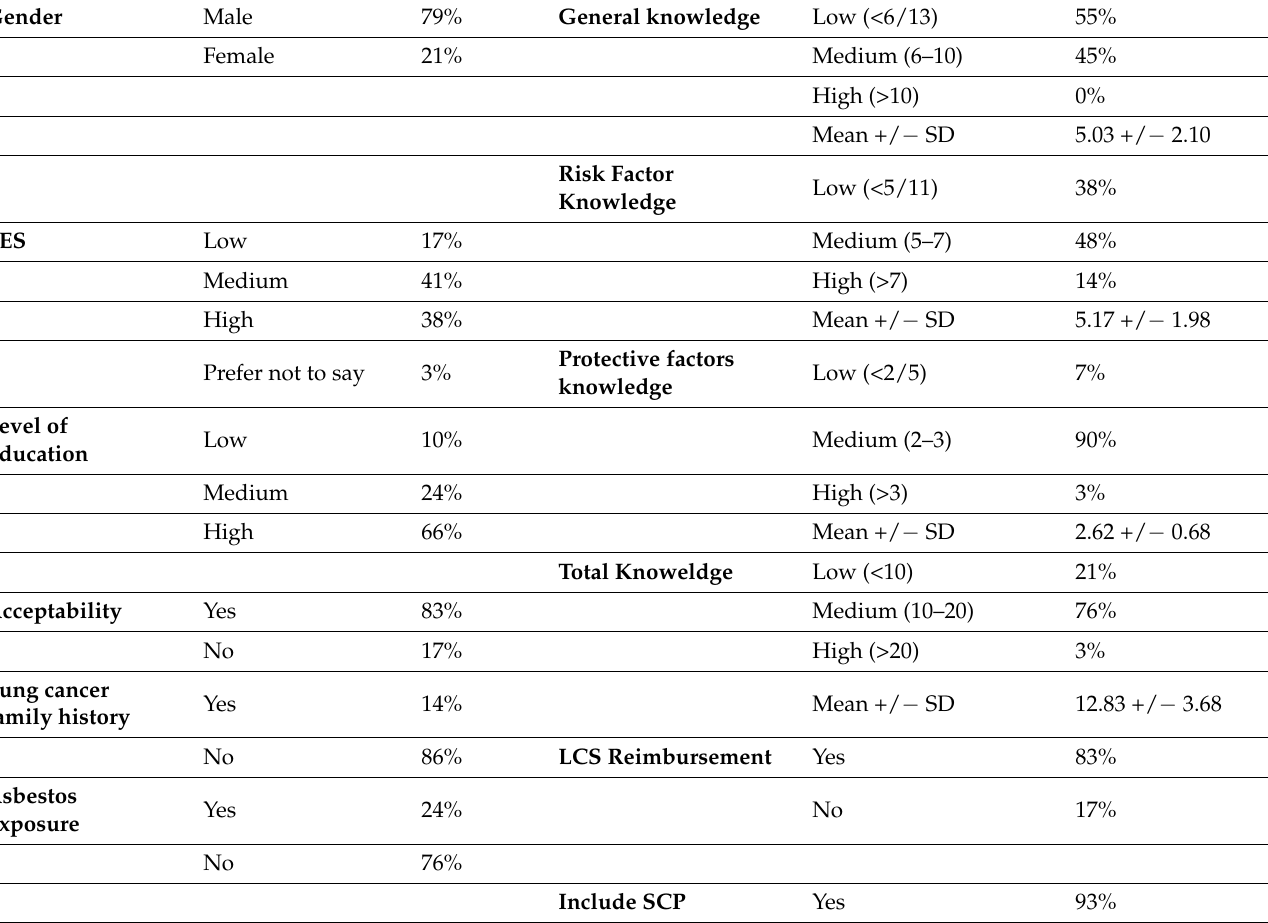
Table A2. Descriptive statistics of variables without missing collected by paper forms (n =